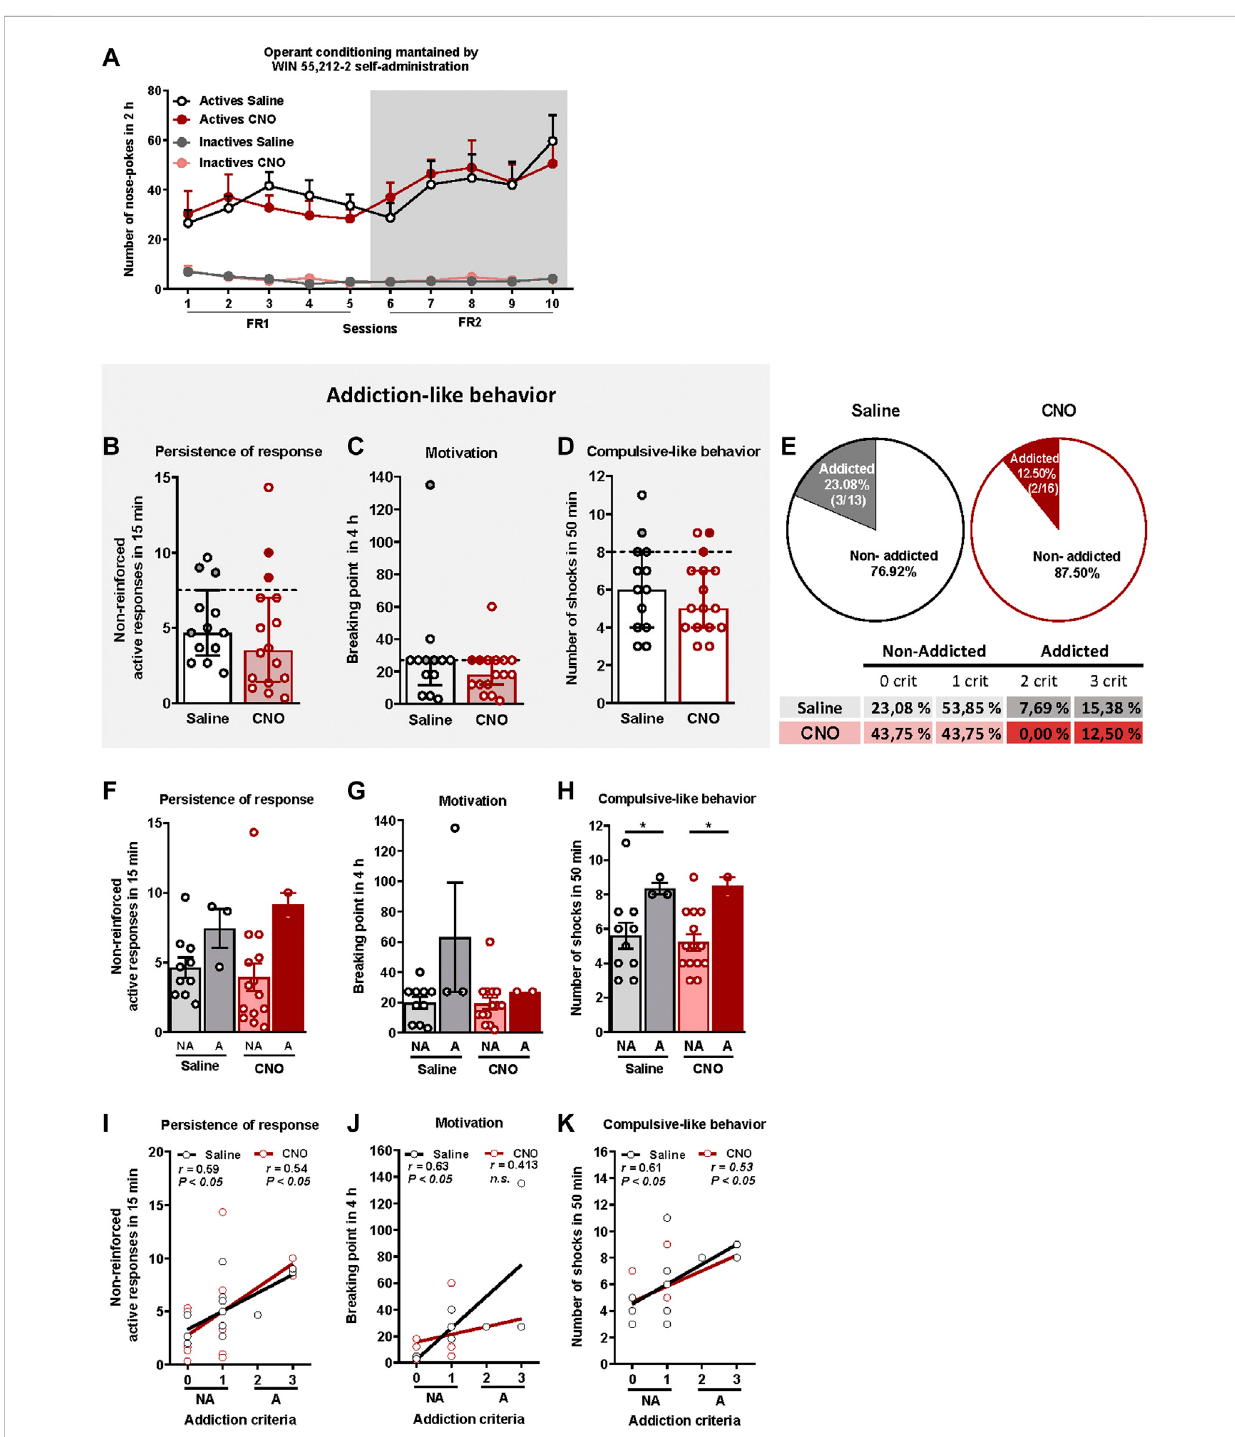
WIN 55,212 – 2 operant self-administration led to the development of an addictive-like phenotype in mice. (A) Similar number of total active and inactivenose-pokesperformedbyCNO-andsaline-treatedgroupsduring2 hofoperantself-administrationmaintainedbyintravenousinfusionsofWIN 55,212 – 2inbothFR1andFR2schedulesofreinforcement(mean±S.E.M.,repeatedmeasuresANOVA). (B – D) Micepresent similarresponses inthethree addiction-like criteria tests (individual data with median and interquartile range): (B) Persistence to response: Number of responses to the active nose-poke during the 15 min drug-free period (Student ’ s t-test). (C) Motivation: Breaking point determined during a 4 h progressive schedule of reinforcementrepresents themaximal number ofresponses that an animal isableto do to obtainone drug infusion (U Mann-Whitney). (D) Compulsivity: Number of shocks received following the schedule described in the Materials and Methods section, re fl ecting the compulsivity level of each group (Student ’ s t-test). The dashed horizontal line indicates the 75th percentile of the distribution of the group, used as the threshold to consider a mouse positiveforonecriterion.Addictedmicearerepresentedingrey-andred- fi lledcircles. (E) Percentageofmicecategorizedasaddicted(Chisquare). (F – H) Behavioraltestsofthethreeaddiction-likecriteriashowingincreasedcompulsivityinaddictedmicecomparedtonon-addictedbutsimilarpersistenceto response and motivation (individual data with mean ± S.E.M., U Mann-Whitney, * p < 0.05). (I – K) Pearson correlations between individual values of addiction-likecriteriaand (I) non-reinforcedactiveresponsesin15 min, (J) breakingpointin4 hand (K) numberofshocksin50 min(Saline-treatedmice: n = 13; CNO-treated mice: n = 16; statistical details are included in Supplementary Table